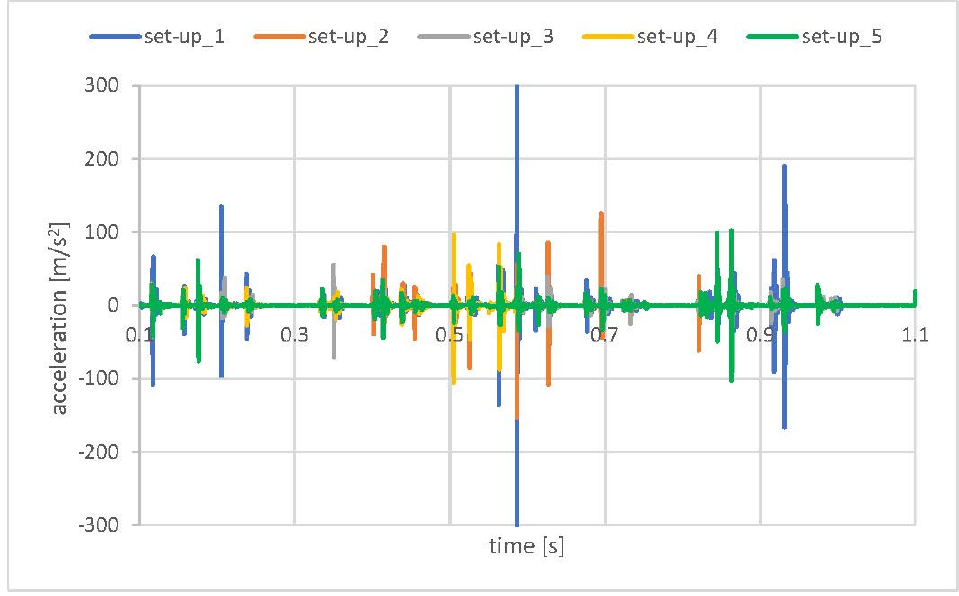
Figure 13. Model sensitivity analysis–CRB accelerations.